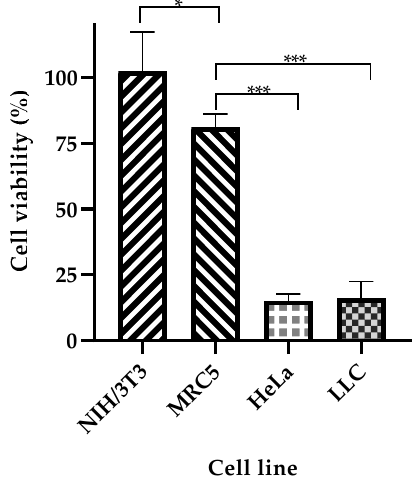
Figure 9. NP-253 decreases the viability of cancerous cell lines compared to non-cancerous cells. Cell viability after treating cancerous (LLC and HeLa cells) and non-cancerous (NIH/3T3 and MRC-5) cells with NP-253 (180 μ g/mL of Cyt c) for 6h. One-way ANOVA, * p = 0.01 and *** p < 0.001, respectively, n = 3. Error bars represent the calculated SD.